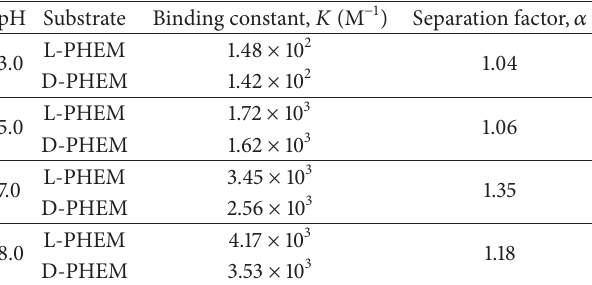
Table3:TheadsorptionofL-PHEMandD-PHEMontheL-PHEM- imprinted polymer.